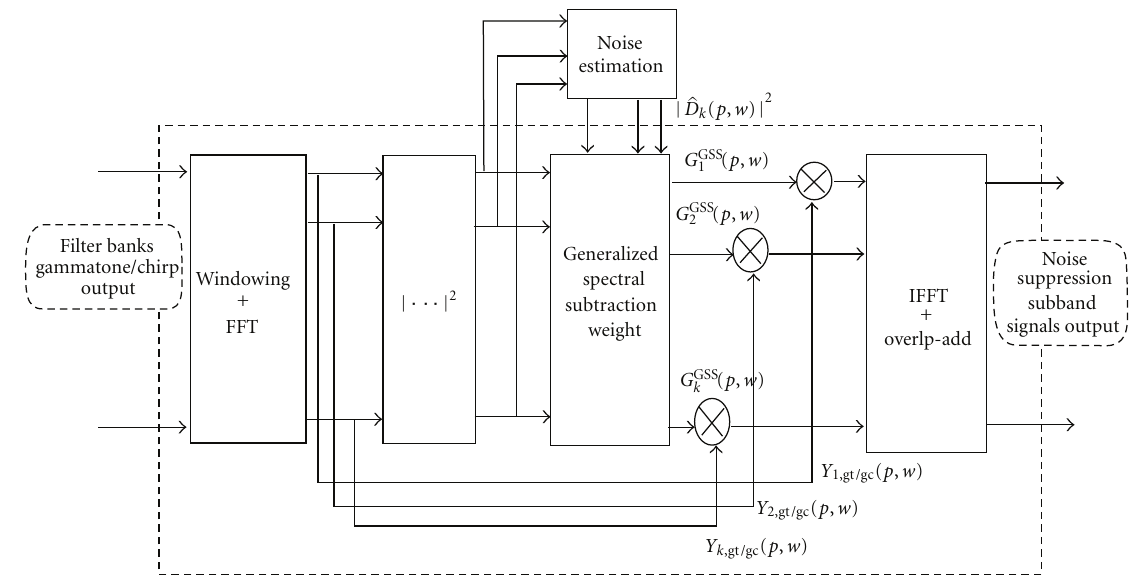
Figure 3: Proposed perceptual generalized spectral subtraction technique applied in a multirate